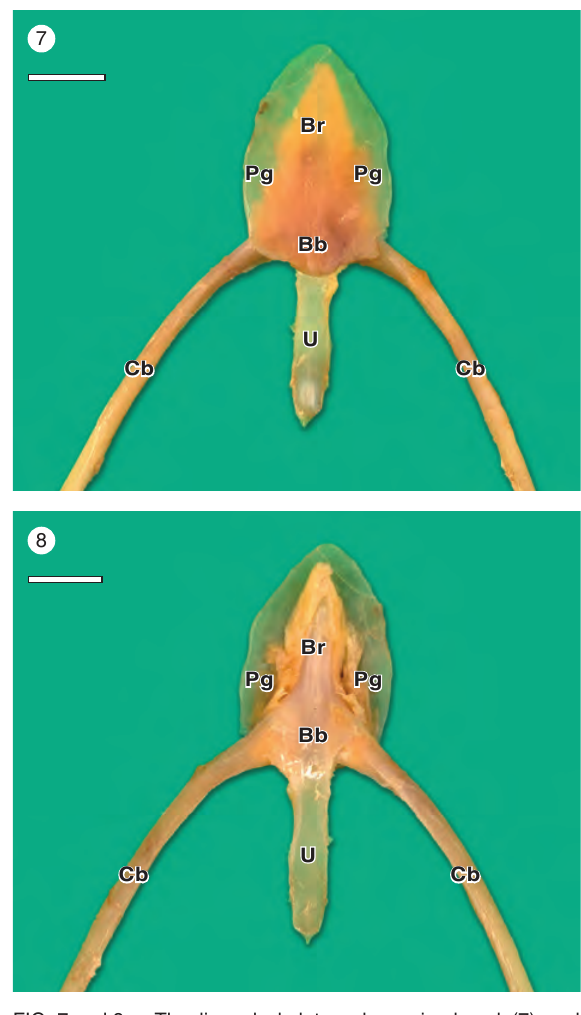
FIG. 7 and 8 The lingual skeleton shown in dorsal (7) and ventral (8) view The broad paraglossum (Pg) lies dorsal to the rostral projection of the basihyale (Br) within the tongue body. The body of the basihyale (Bb), the rostral parts of the paired ceratobranchiale (Cb) and the urohyale (U) are all imbedded within the frenulum (see Fig. 6). Bar = 5